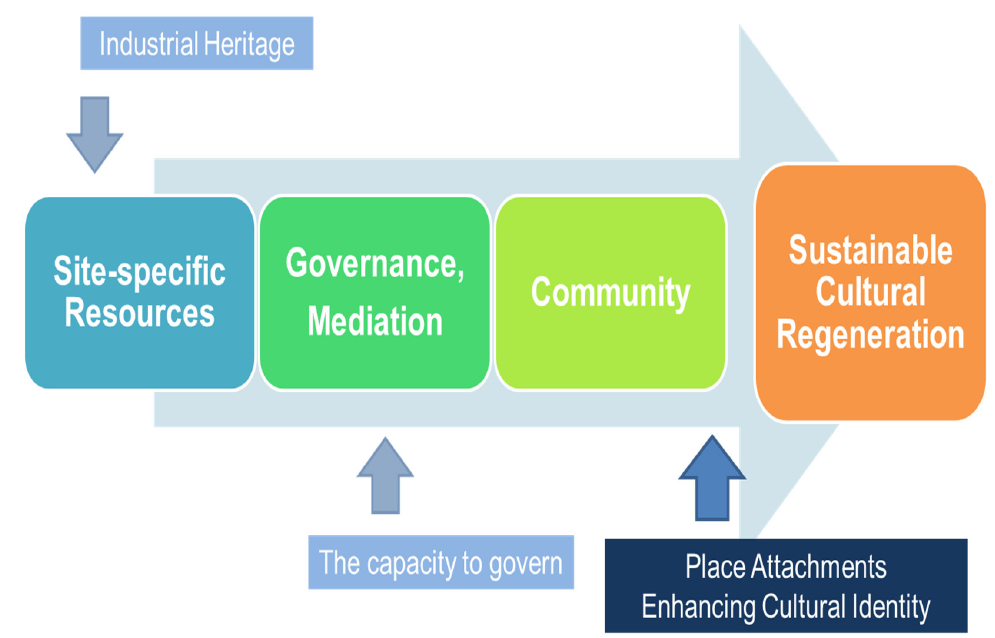
Figure 6. Sustainable cultural rurban regeneration in Gunsan.